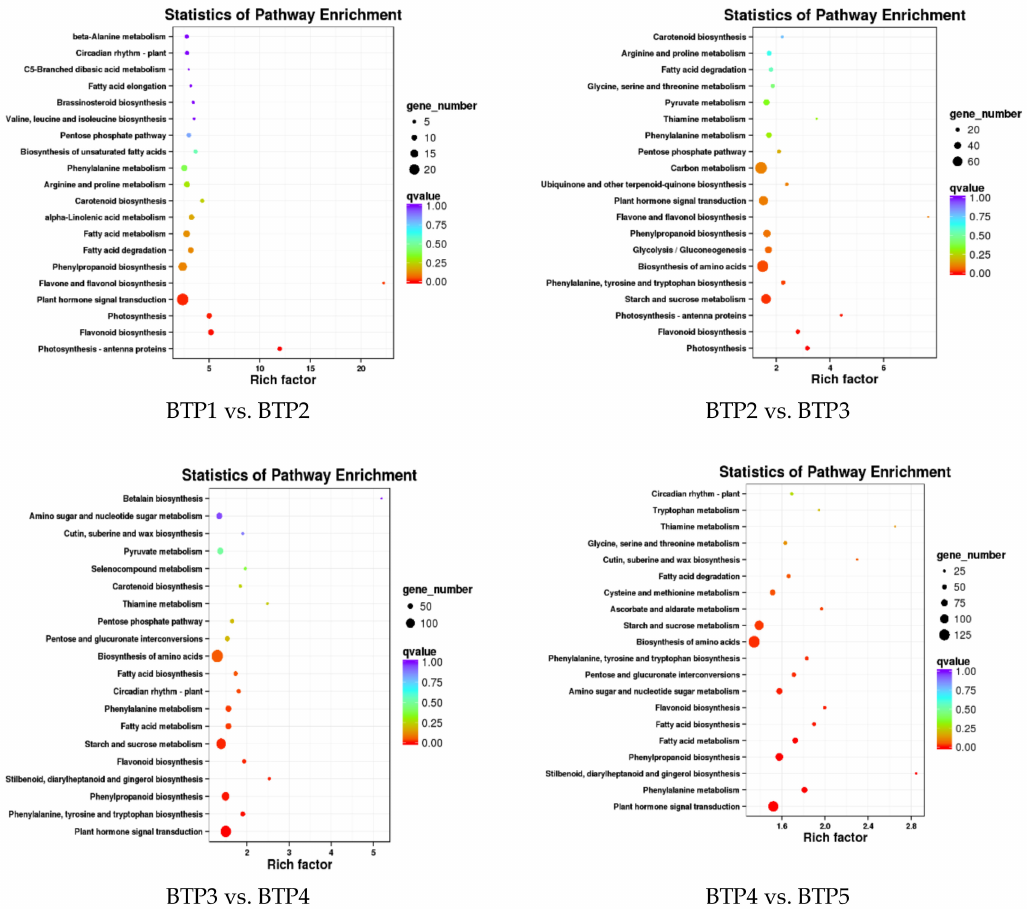
Figure 6. KEGG enrichment analysis of DEGs in different tea development